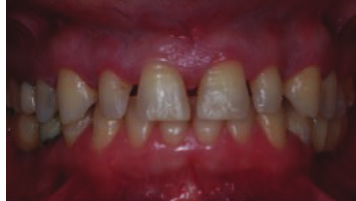
Figure 4: Surgical guide manufactured with silicone.